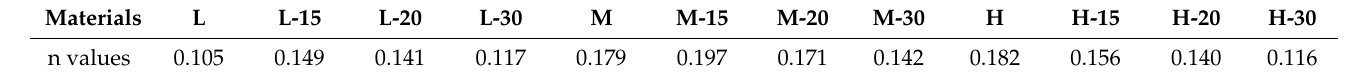
Figure 7. The relation n(ε) between the strain hardening component n and true strain of composites. the results of n(ε) of composites using ( a ) matrix L, ( b ) matrix M, and ( c ) matrix H are shown together with the n(ε) of their matrices. The value of the dash line is the average of n value in deformation stage of the composite in same color, and these n values are shown in Table 3. Table 3. The strain hardening components n of composites and their matrices.